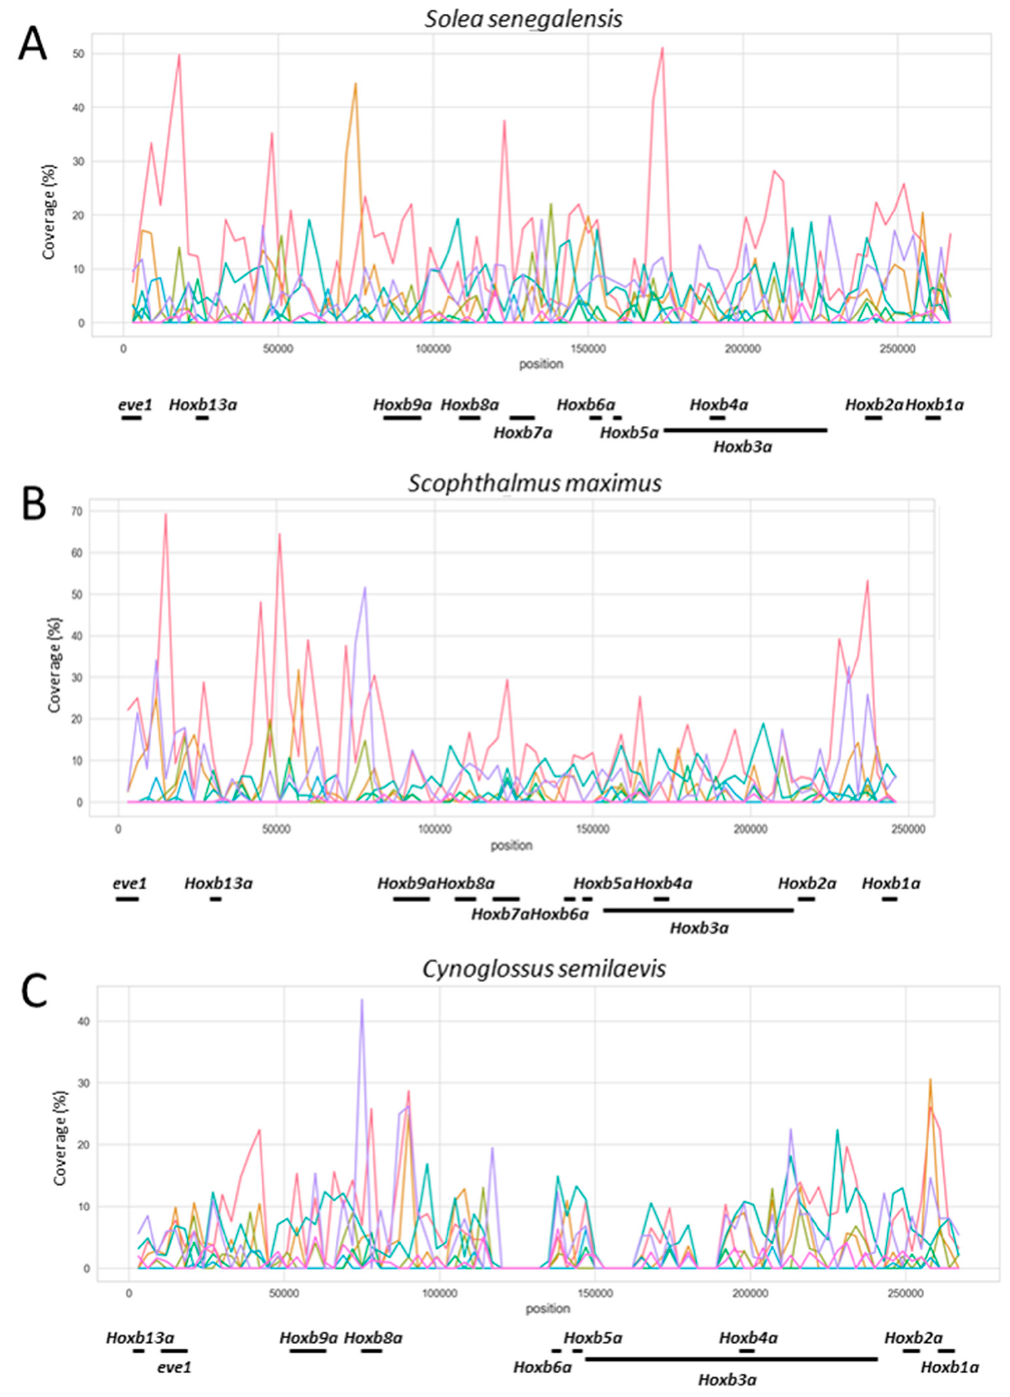
Figure 3. Abundance of repetitive elements measured as coverage (%) throughout the hoxba cluster sequence of three flatfish species (sliding window 3 kb): ( A ) Solea senegalensis , ( B ) Scophthalmus maximus , and ( C ) Cynoglossus semilaevis . Repetitive elements analyzed were: DNA transposons (light red), LINEs (light orange), LTRs (light green), RC/Helitrons (green), Simple repeats (blue green), SINEs (sky blue), Unknown (purple), and Low-complexity sequences (pink). Coverage is measured as the percentage of length occupied by repeated elements.